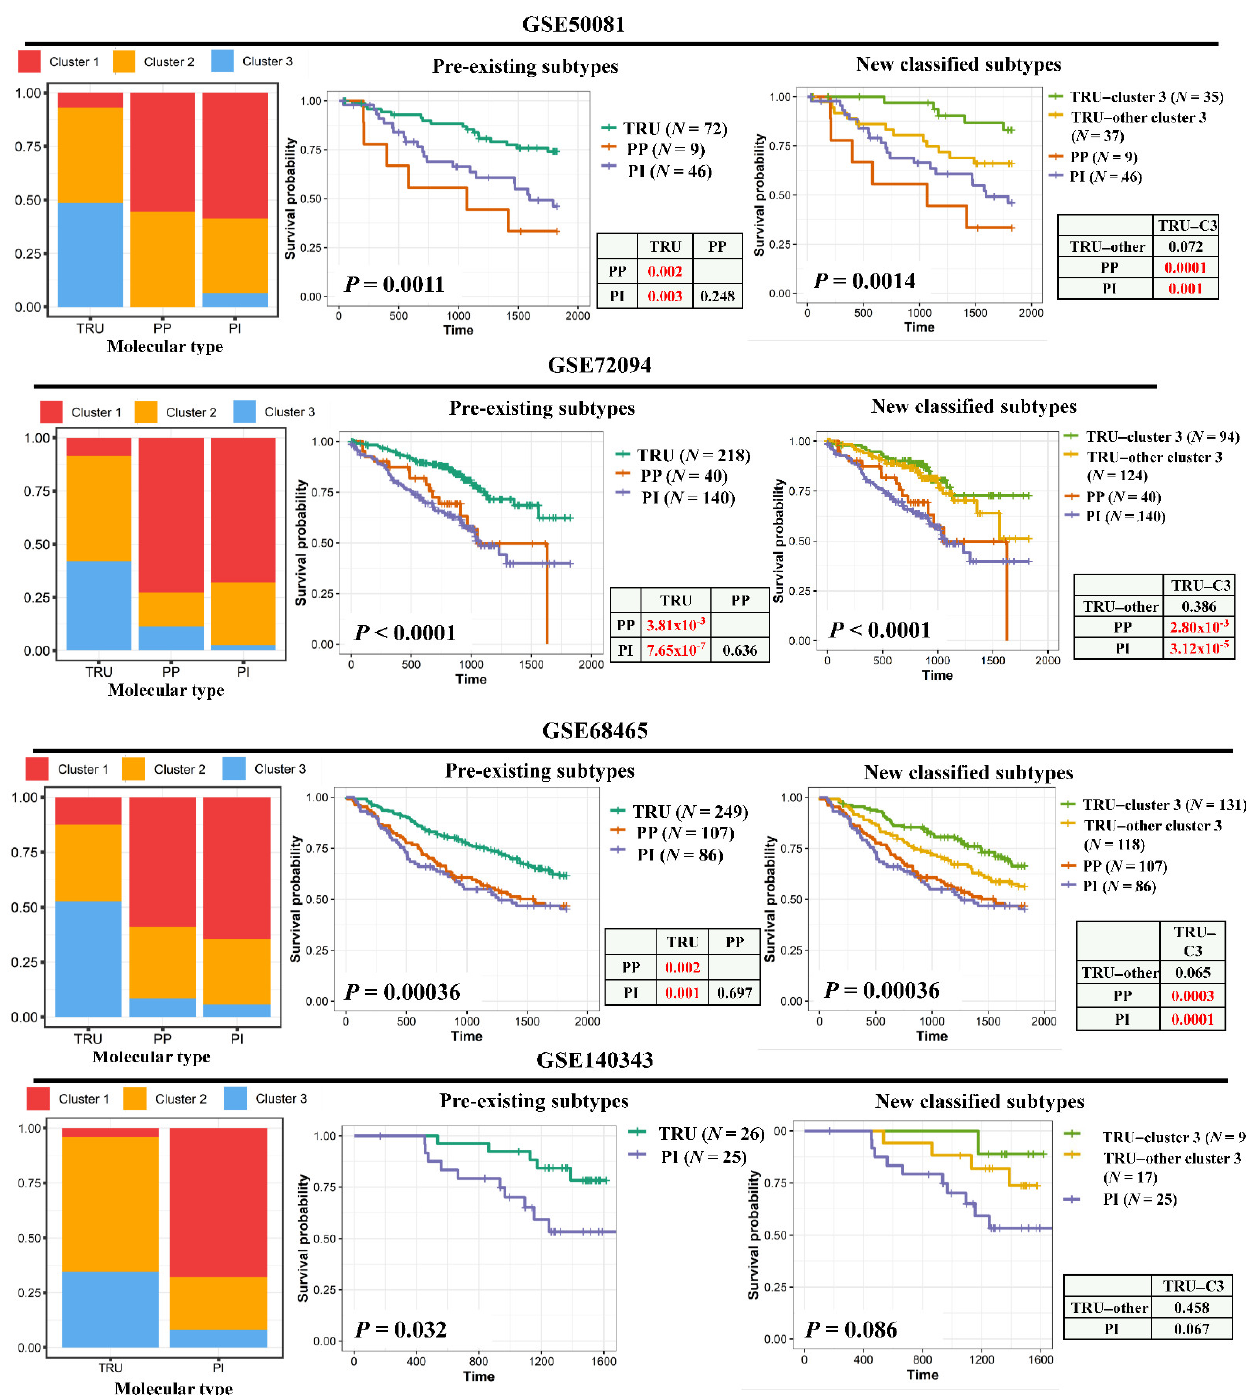
Figure 4. Validation of survival and molecular differences of essential gene-stratified clusters of multiple GEO data. ( A ) Kaplan-Meier plots demonstrating survival differences of essential gene-classified clusters in the GSE140343, GSE68465, GSE72094, GSE50081, and GSE31210 datasets. Survival differences were evaluated using log-rank tests. ( B ) Forest plot using multivariate Cox regression analyses showing essential gene-classified clusters as an independent prognostic factor in the GSE68465, GSE72094, GSE50081, and GSE31320 datasets. ( C ) Distributions of essential gene-classified clusters in previously reported expression subtypes shown in stack bar plots. Kaplan-Meier plots demonstrated survival rates of different molecular types with or without considering cancer essential gene-classified clusters. * means p < 0.05.